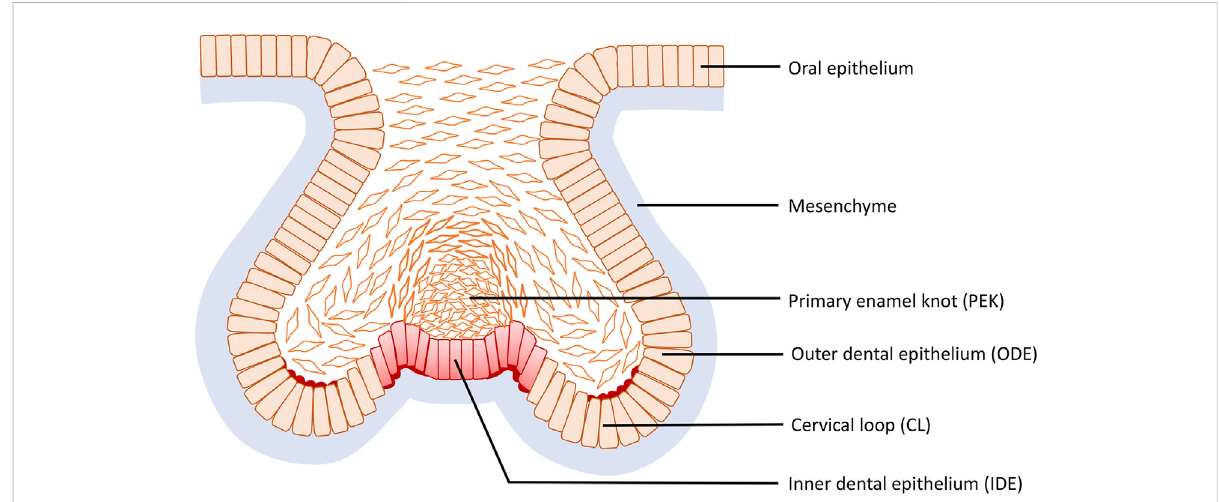
FIGURE 6 Reverse curve morphogenesisat the base of thetooth germ during tooth development. Reverse curvesoccur at three sites: the fi rst is found in the neck region of the tooth bud continuing to the outline of the germ body; the second is formed by the cervical loop (CL) present bilaterally at the foldconnectingtheouterdentalepithelium(ODE)andthelateralportionoftheinnerdentalepithelium(IDE),whilethethirdissituatedintheprimary enamel knot (EK) centered in the IDE with an invaginated